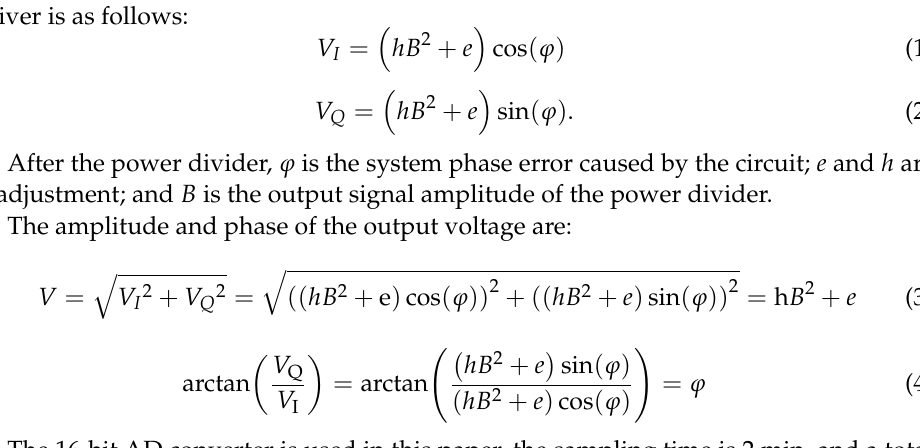
Table 1. Part of the actual experimental measurement results.